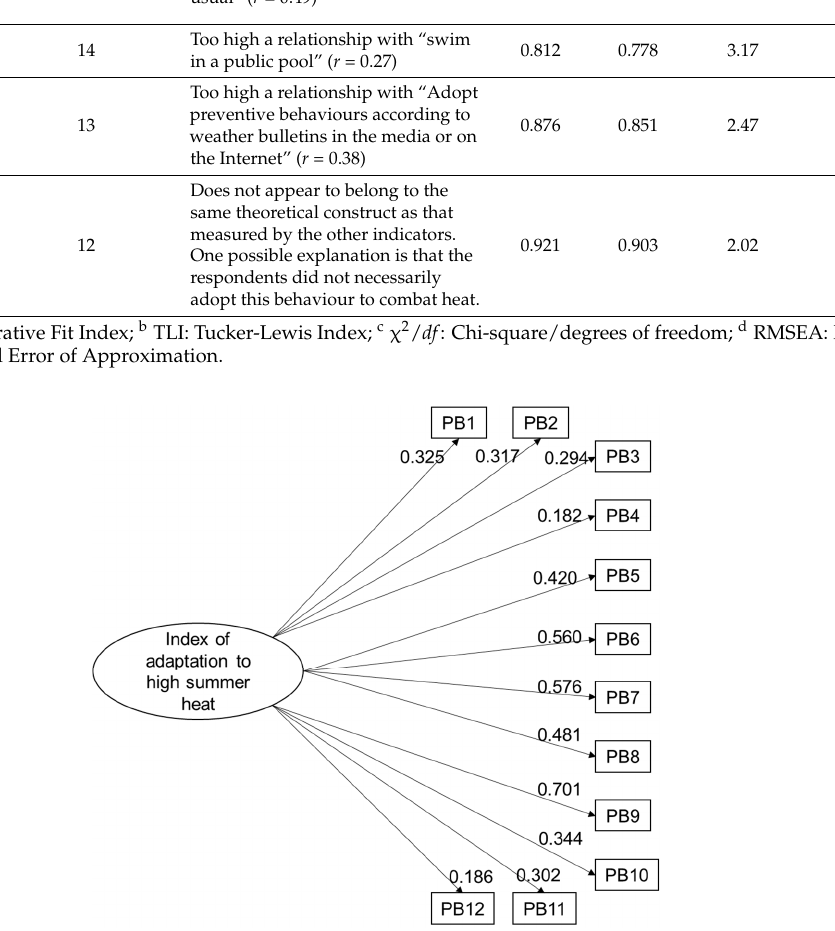
Figure 1. Results for the final model tested with a confirmatory factor analysis. Legend: PB1.